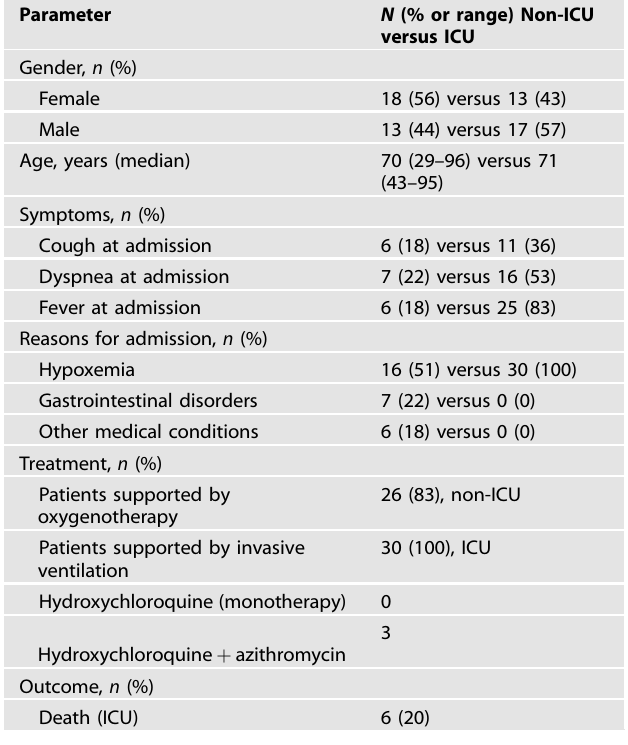
Table 1. Clinical characterization of ICU and non-ICU